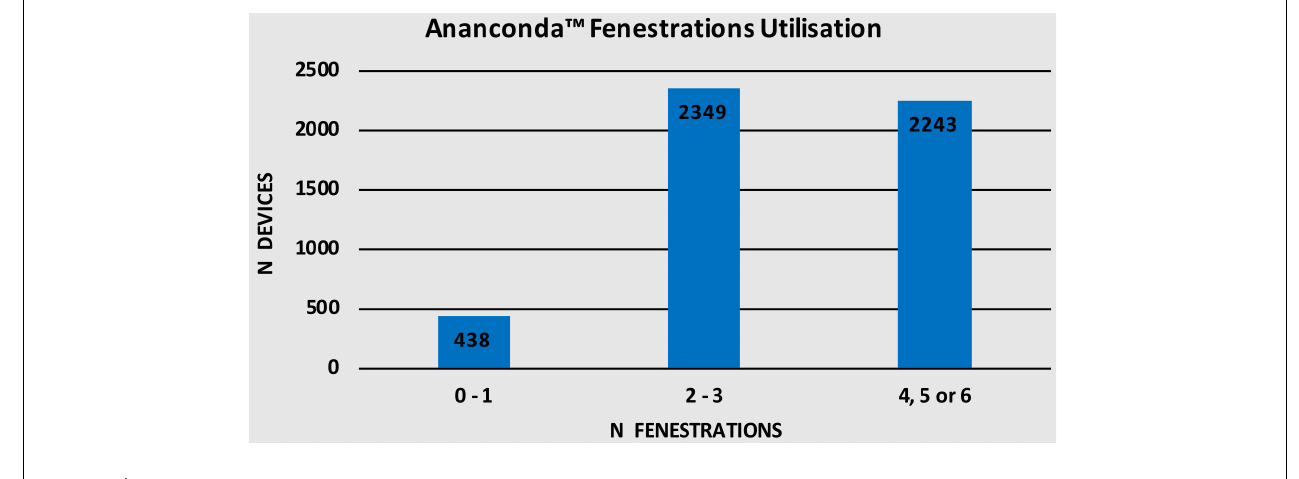
FIGURE 7 | Number of fenestrations used.